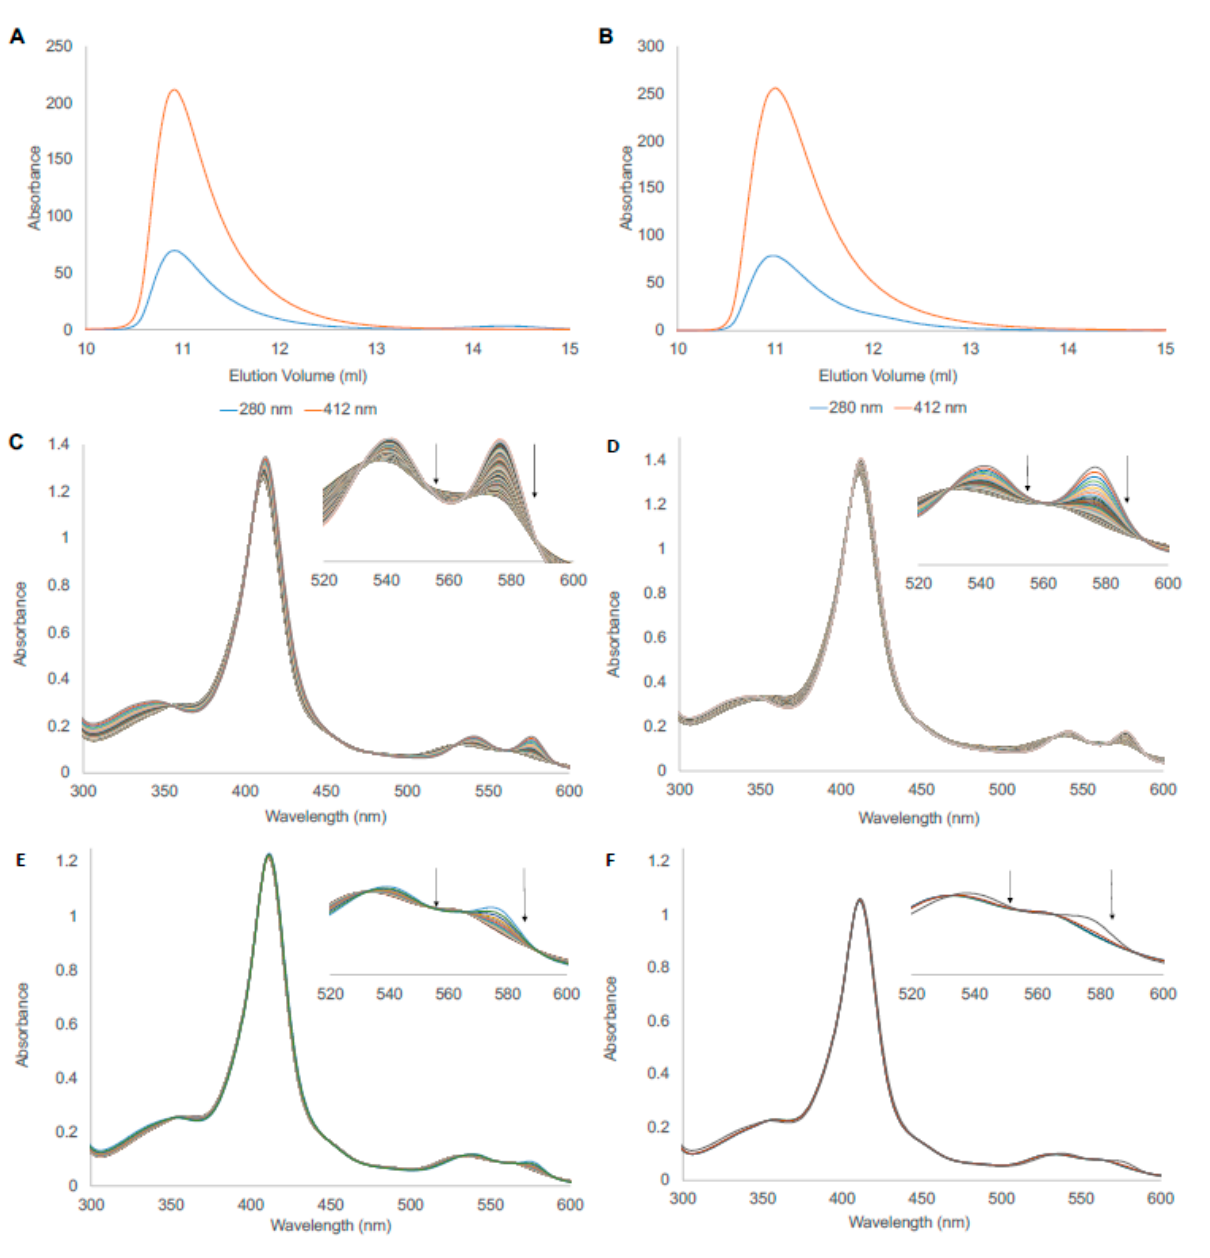
Figure 1. Size-exclusion chromatography and autoxidation measurements of BvPgb1.2 WT and Cys86Ala. ( A , B ) BvPgb1.2 WT and Cys86Ala, respectively. Data form 280 nm (protein backbone absorption) and 412 nm (heme-containing proteins) are presented. Both species eluted ~10.9 mL, corresponding to a molecular weight ~40 kDa (Supplementary Figure S1). ( C , D ) Complete autoxi- dation spectra for BvPgb1.2 WT 25 °C and WT at 37 °C, respectively. ( E , F ) Complete autoxidation spectra for BvPgb1.2 Cys86Ala 25 °C and Cys86Ala at 37 °C. For the autoxidation, a zoomed-in view is presented in the 500–600 nm range for depiction of the oxidation process from the ferrous to ferric oxidation state (Fe II → Fe III